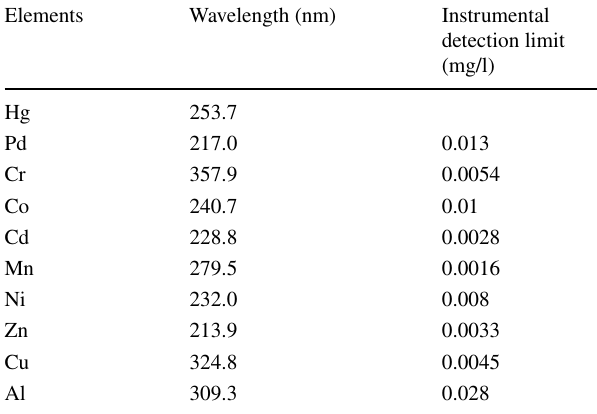
Table 1 Spectral lines used in emission measurements and the instru- mental detection limit for the elements measured by using ICP–AES Elements Wavelength (nm) Instrumental detection